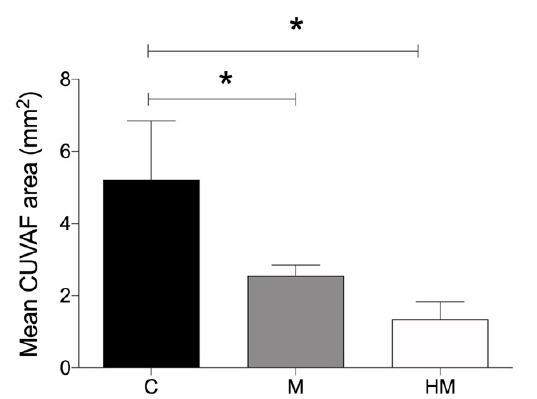
Figure 6. Analysis of mean CUVAF area (mm 2 ) in spectacle wearers of the control and myopic groups. CUVAF: conjunctival ultraviolet autofluorescence. C: control group (>1.00 D); M: myopic group ( ≤ 1.00 D); M1: − 1.00 to − 3.00 D; M2: − 3.25 to − 5.75 D; HM: High myopia ( ≤− 6.00 D or >26 mm LA). Significance p < 0.05. * p < 0.05.